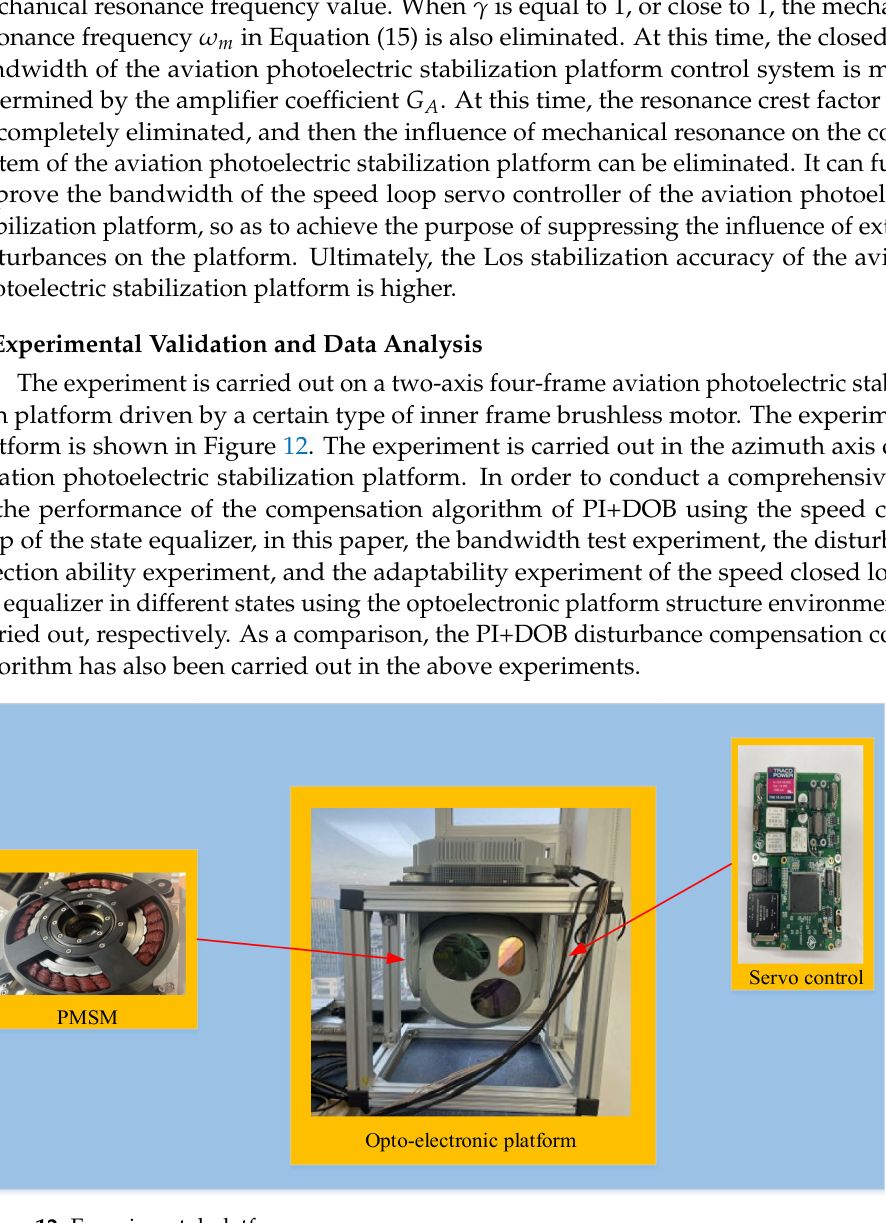
Figure 12. Experimental